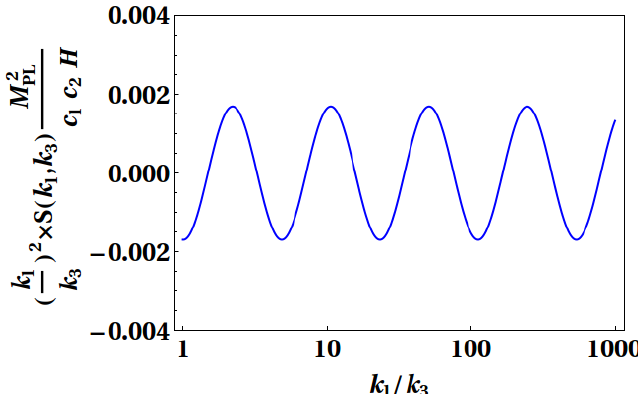
Figure 6 . The cosmological collider signal ( k k 1 =k 3 with (cid:22) =